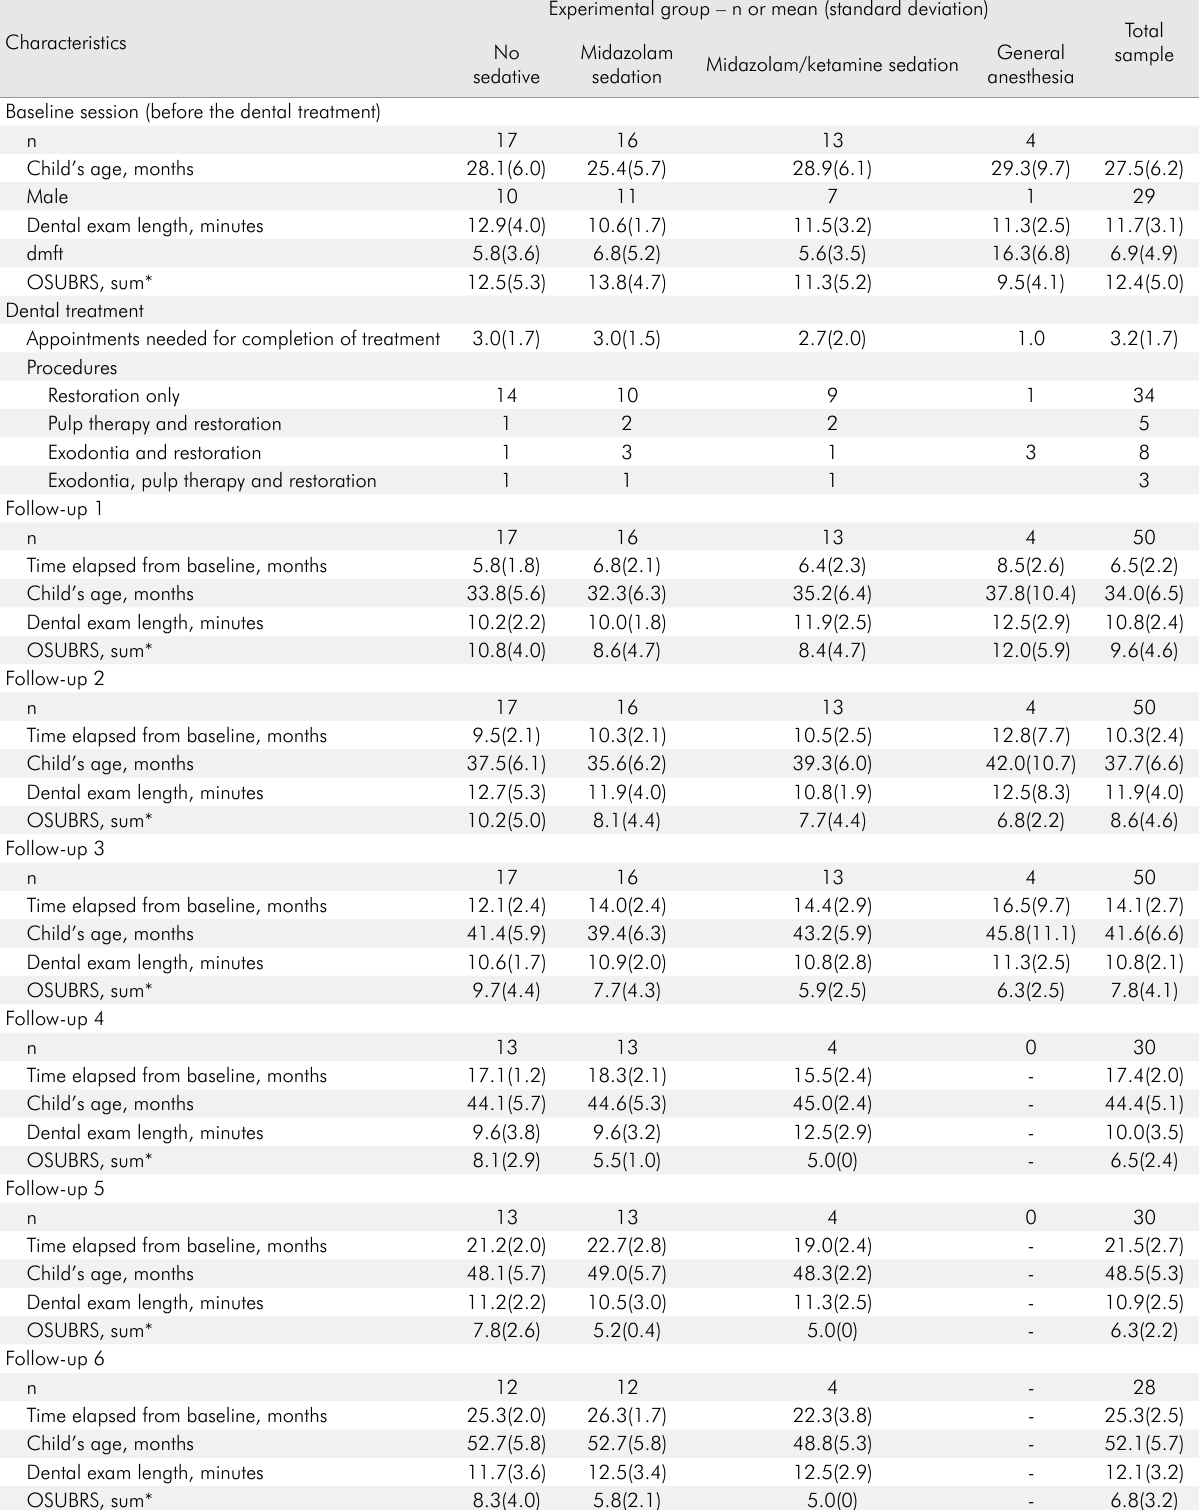
Table 1. Children’s demographic information and dental sessions’ characteristics by the experimental group.